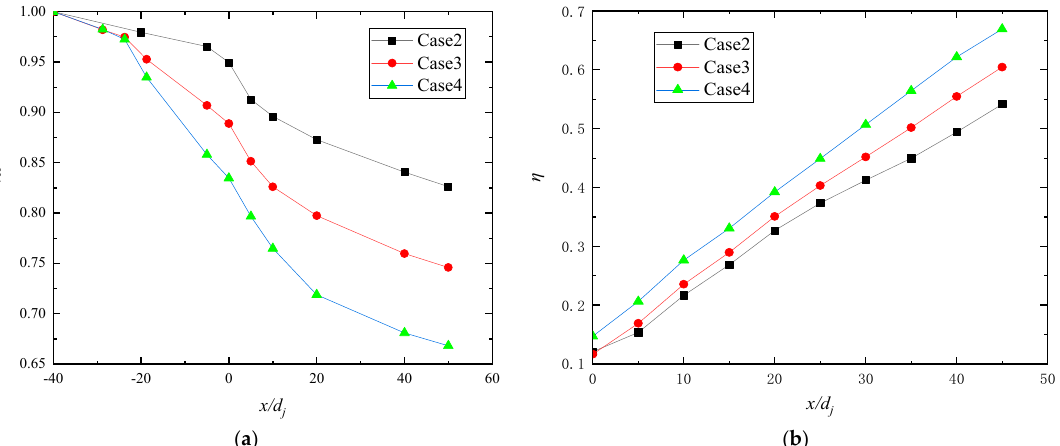
Figure 14. Comparison of mixing parameters along the flow direction of Case2, Case3, and Case4. ( a ) Total pressure recovery coefficient. ( b ) Mixing The impact of the angle of SWG is shown in Figures 15 and 16. Based on the unilateral setting of the SWG, the total pressure recovery coefficients of Case2, Case3, Case5, and Case7 decrease successively after x/d j = − 10. At x/d j = 40, the total pressure recovery coeffi- cients of Case5, Case3, and Case7 decrease 3.4%, 9.7% and 16.5%, respectively, compared with Case2. In terms of mixing efficiency, the opposite conclusion is presented. At x/d j = 40, the mixing efficiency of Case5, Case3, and Case7 is 3.9%, 12.3%, and 30.0% higher than that of Case2, respectively.